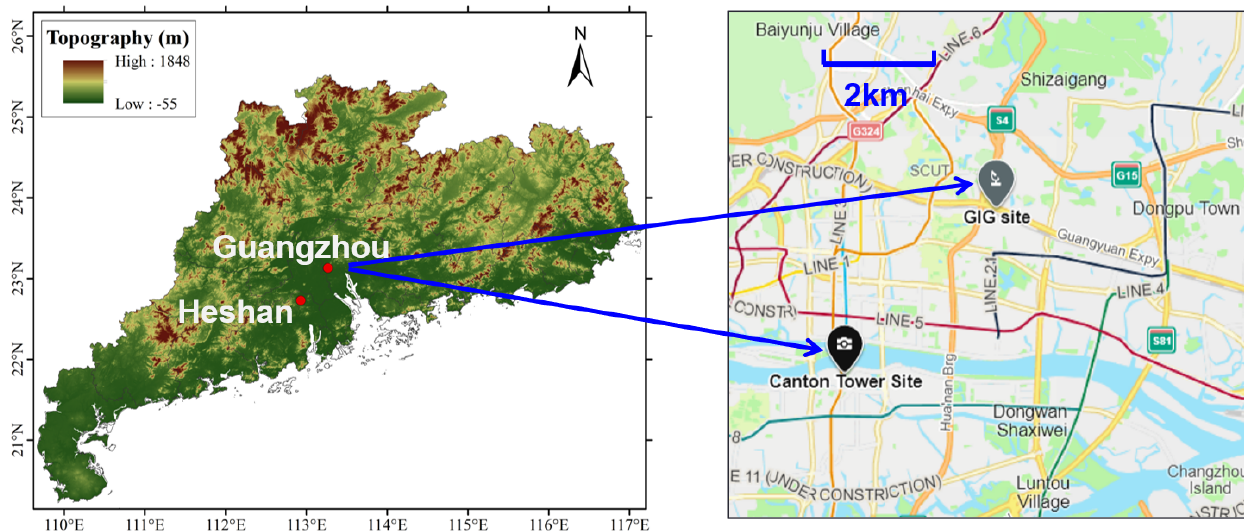
Figure 1. Sampling site at Guangzhou Institute of Geochemistry, Chinese Academy of Sciences (GIG), Heshan and Canton Tower. Note that the map is extracted from © Microsoft Bing maps by the